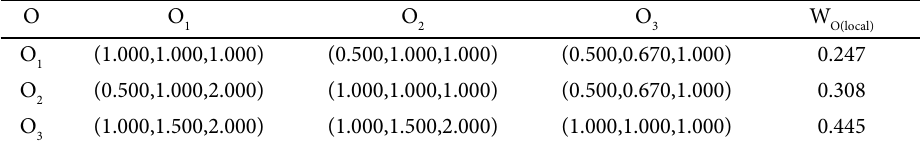
Table 9. Pair-wise comparison matrices and local weights for “O”-group factors